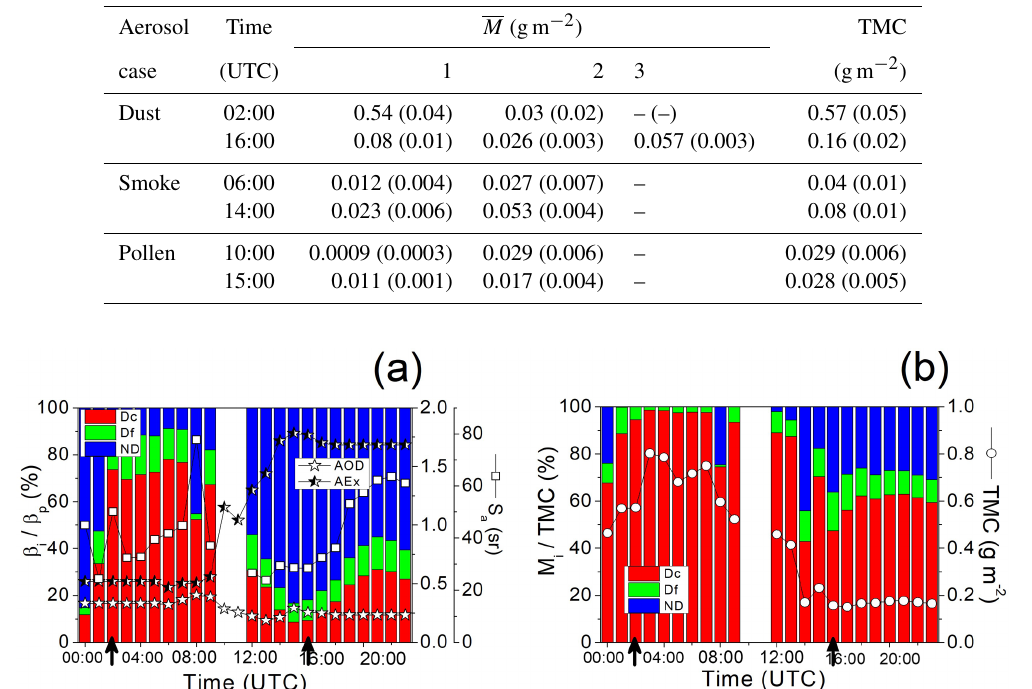
of 0 . 6 ± 0 . 1 and 0 . 2 ± 0 . 1 g m − 2 are estimated at those